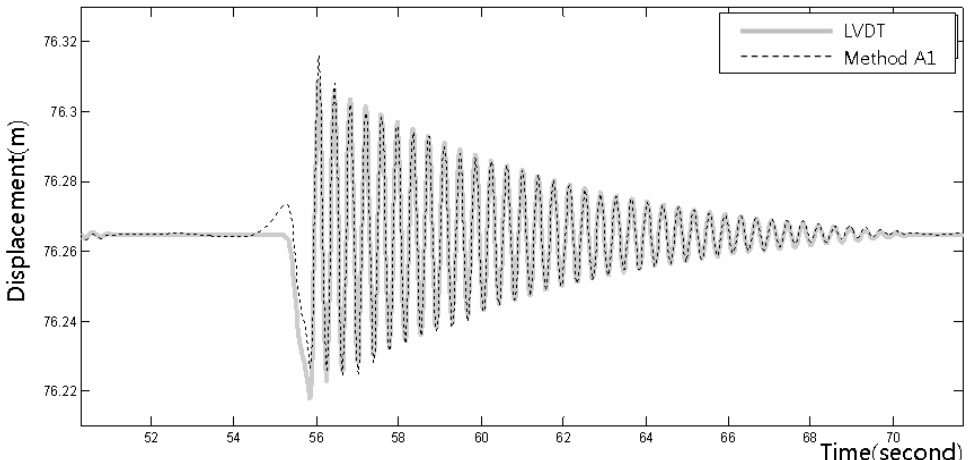
Figure 8. Displacement measurements from the LVDT and the accelerometer (Method